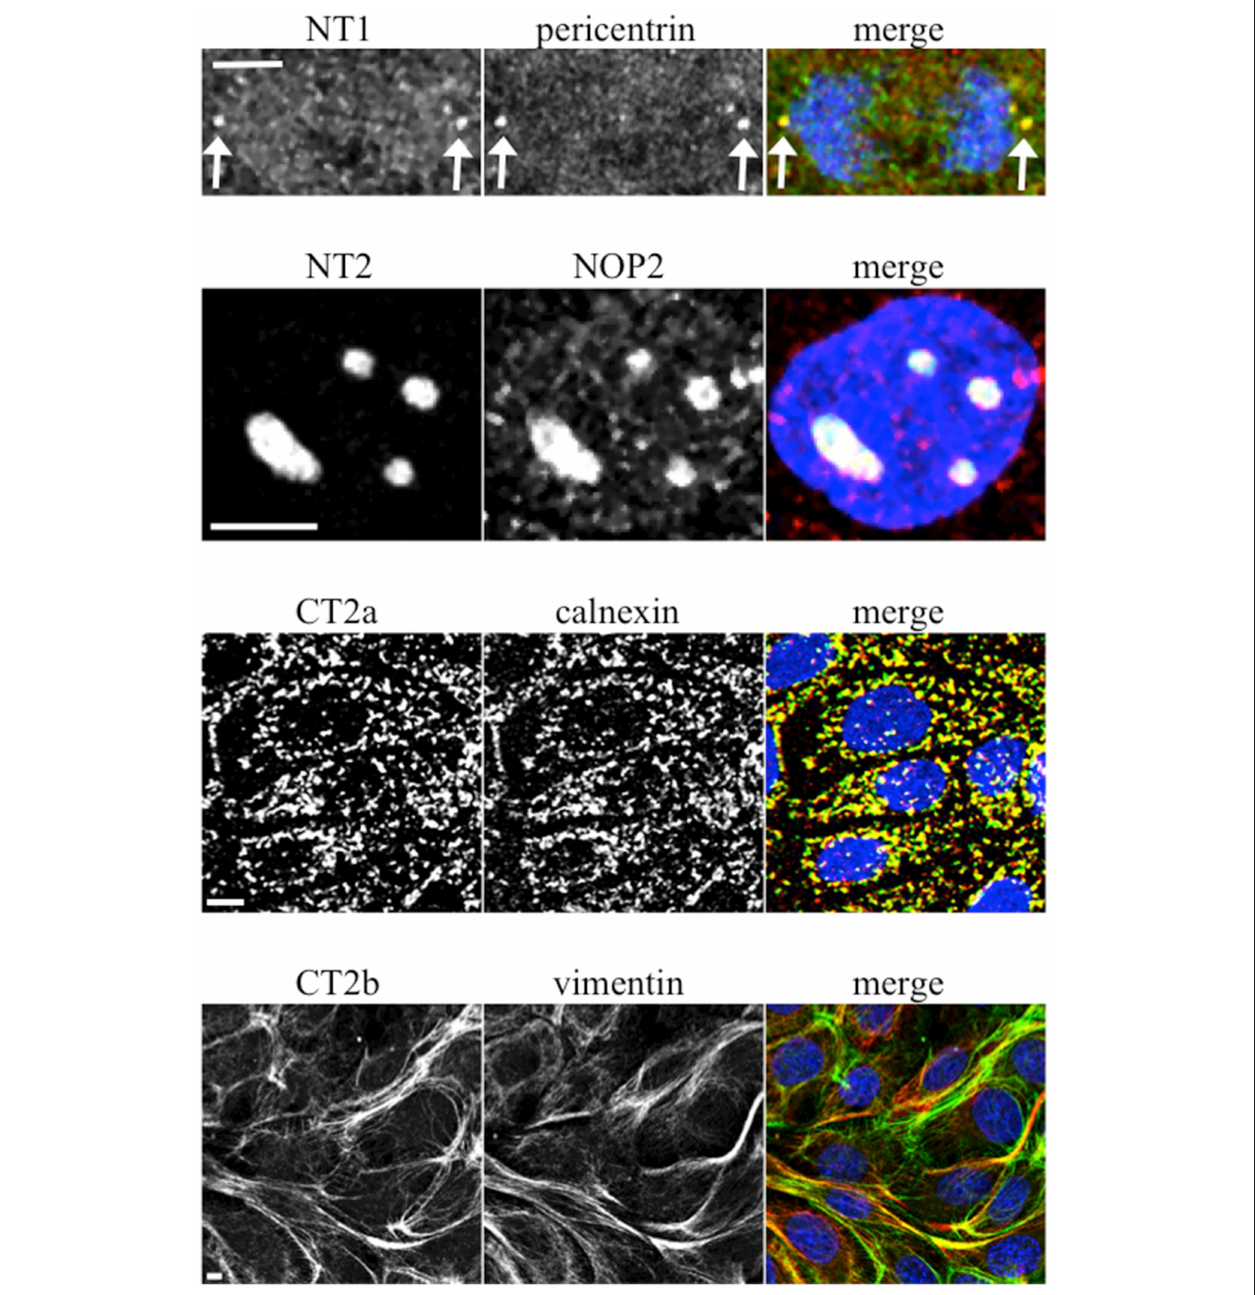
FIGURE 4 | Characterization of novel Sec6 localizations. MDCK cells were fixed as described for Figure 2A and co-labeled with antibodies to Sec6 NT1 (mAb 13F10), NT2 (mAb 16G4), CT2a (mAb 3F3), or CT2b (mAb 11A2) (green) and antibodies to indicated proteins (red). In panels showing merged images, DNA was labeled with DAPI (blue). Bars = 5 µ